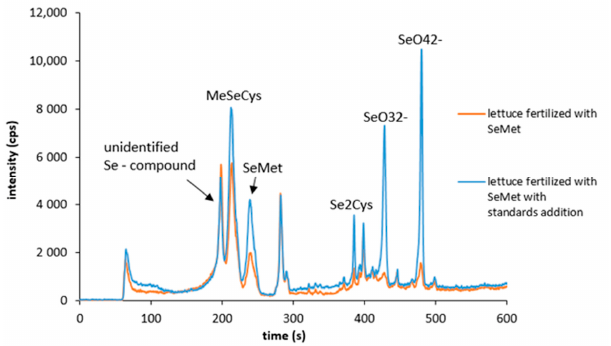
Figure 2. Chromatogram of lettuce extract derived from plants grown in selenomethionine (SeMet)-enriched medium and a chromatogram of the same lettuce extract with MeSeCys, SeMet, Se 2 Cys, SeO 3 − 2 and SeO 4 − 2